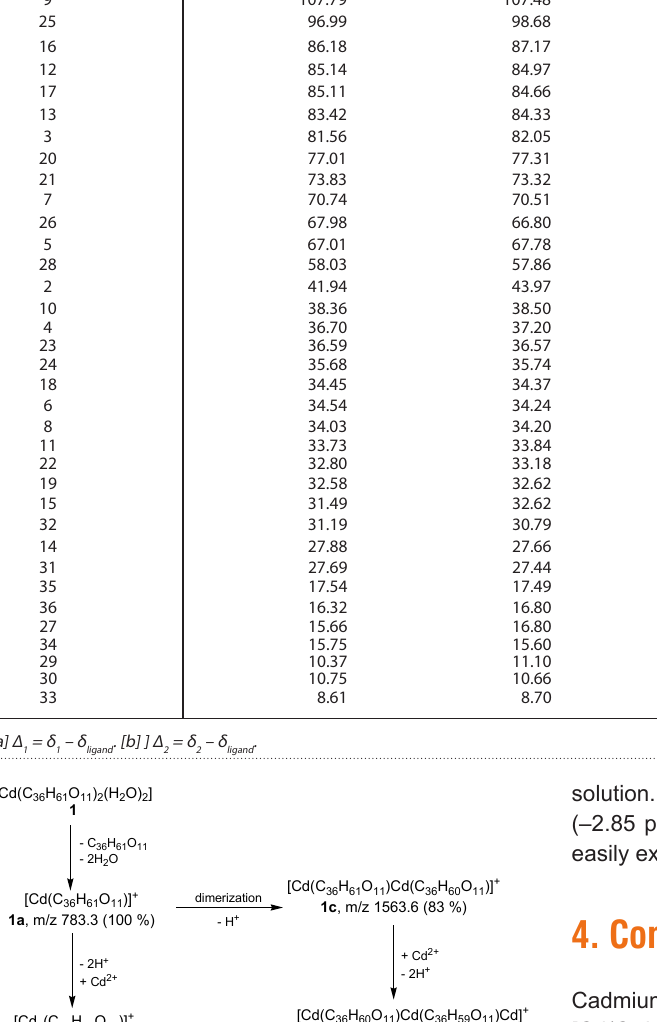
/TMS) of monensic acid and complexes 1 - 2 3